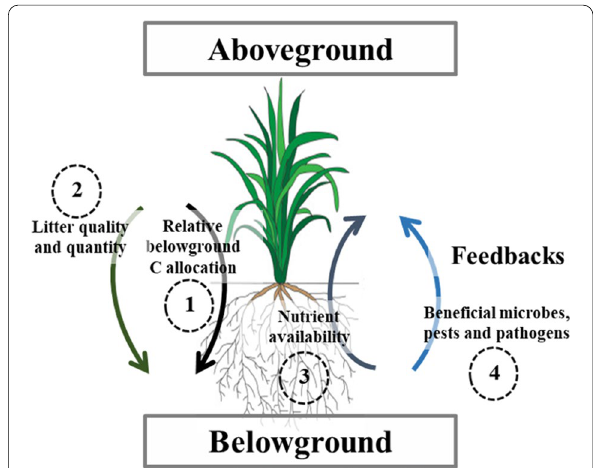
Fig. 1 The main pathways involved in plant–soil feedbacks. Plants predominantly influence belowground communities and soil chemistry through changes in belowground carbon allocation (1) and litter quality and quantity (2). Changes in plant inputs influence belowground communities and soil processes, which in turn influence the plant by changing nutrient availability (3) and by modifying plant interactions with beneficial microbes and pests and pathogens (4). Plant–soil feedbacks represent the net effect of the strength and direction of the combined